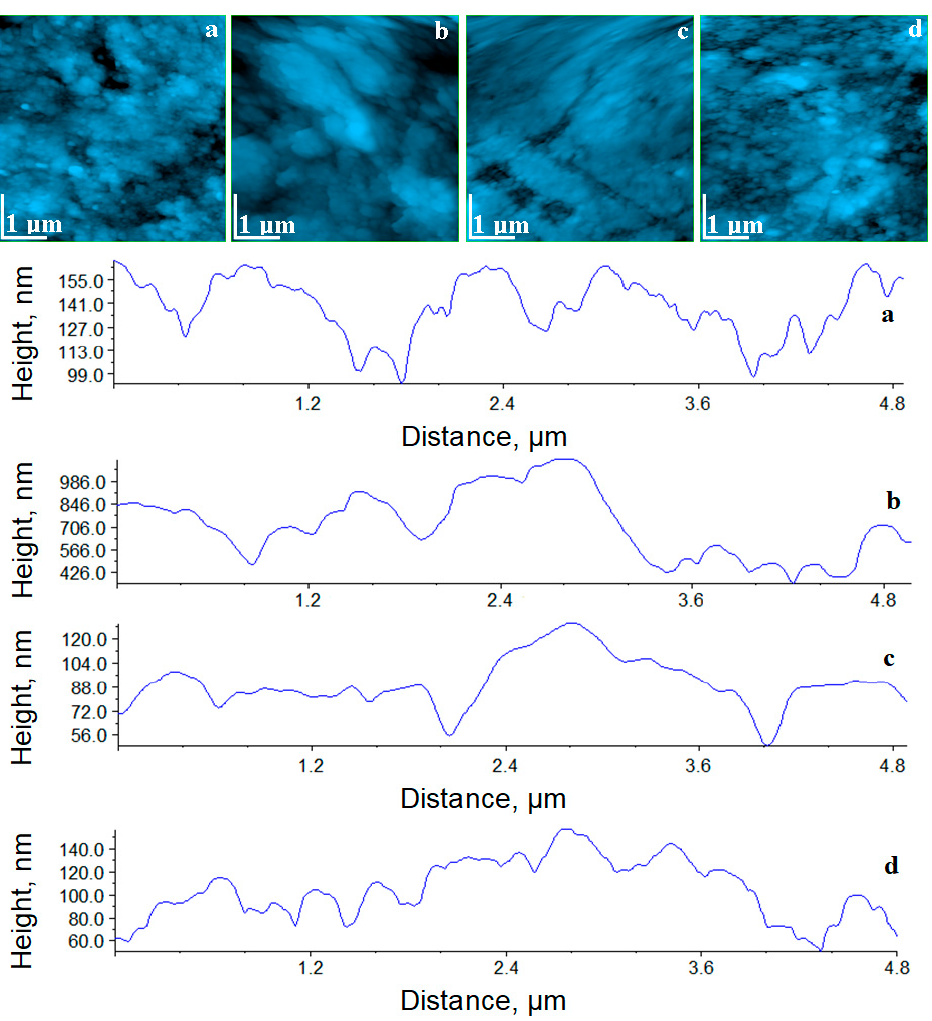
Figure 5. AFM topographic images for the samples exposed to saliva: ( a ) Adoro, ( b ) Variolink, ( c ) Relyx, and ( d ) Solidex. Profiles on the horizontal median of each image are provided.